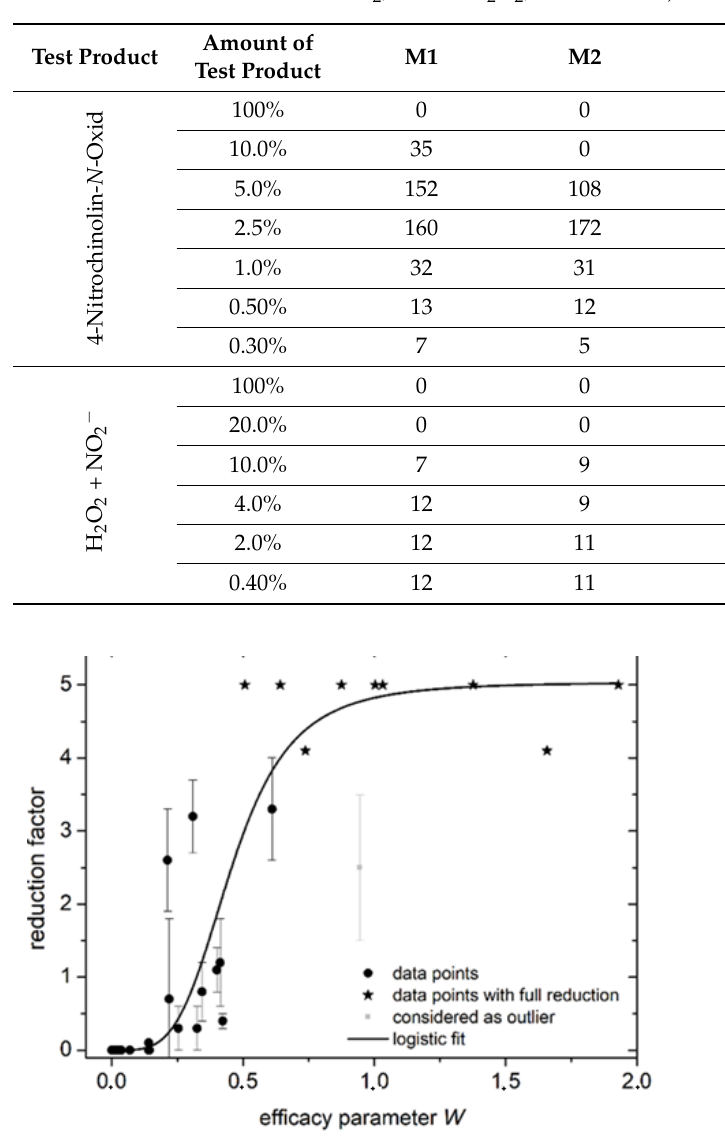
Figure 4. Scatter plot of reduction factor and efficacy parameter W Table 2. cfu per plate of individual measurements (M1 to M3) after treatment with 4-Nitroquinoline- N -oxide (100% = 100 µg per plate) or ONOOH-solution (100% = the initial concentration in mixed solution amounted to 25 mM NaNO 2 , 25 mM H 2 O 2 , 1% citric acid).